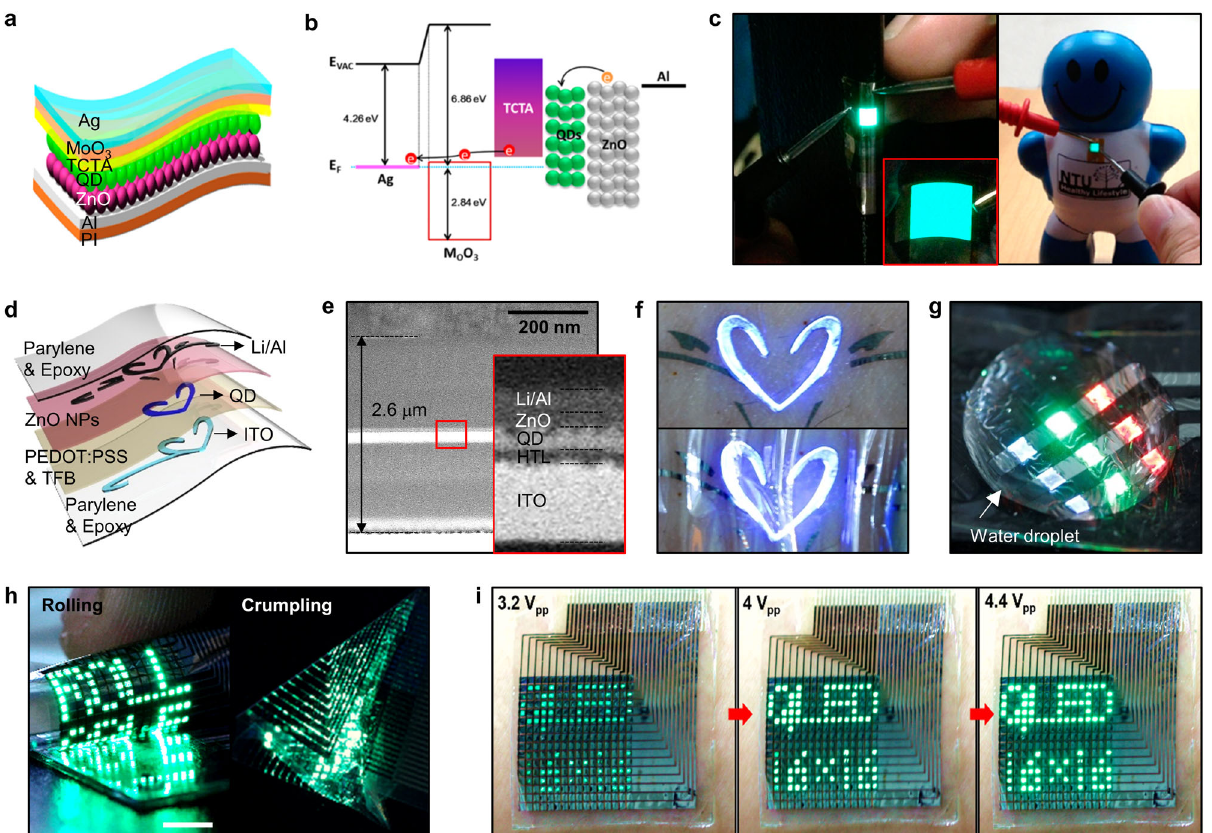
Fig. 7 Wearable quantum dot display. a , b Schematic illustration ( a ) and energy diagram ( b ) of the sticker-type top-emission QLED fi lm. c Curved QLEDs on the edge of a thin steel plate (left) and on curvilinear surface of a toy (right). Inset of the left image shows a large-area QLED on a fl exible substrate (20 mm × 25 mm). d , e Schematic illustration ( d ) and cross-sectional SEM image ( e ) of the tattoo-like wearable QLED. Inset of ( e ) shows the magni fi ed device structure. f Ultrathin tattoo-like QLEDs laminated on human arm. g Waterproof properties of ultrathin QLEDs. h Ultrathin QLED display (left: rolling, right: crumpling). i Sequential images of the QLED display with different operating voltages. Figure reproduced with permission from: a – c ref. 149 © 2014 ACS; d – g ref. 99 © 2015 NPG; h , i ref. 51 © 2017